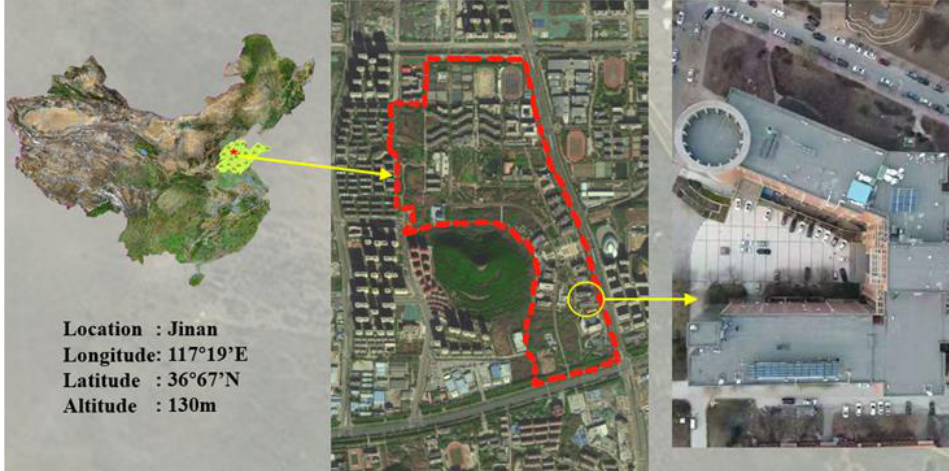
Figure 1. Satellite image of the study area.